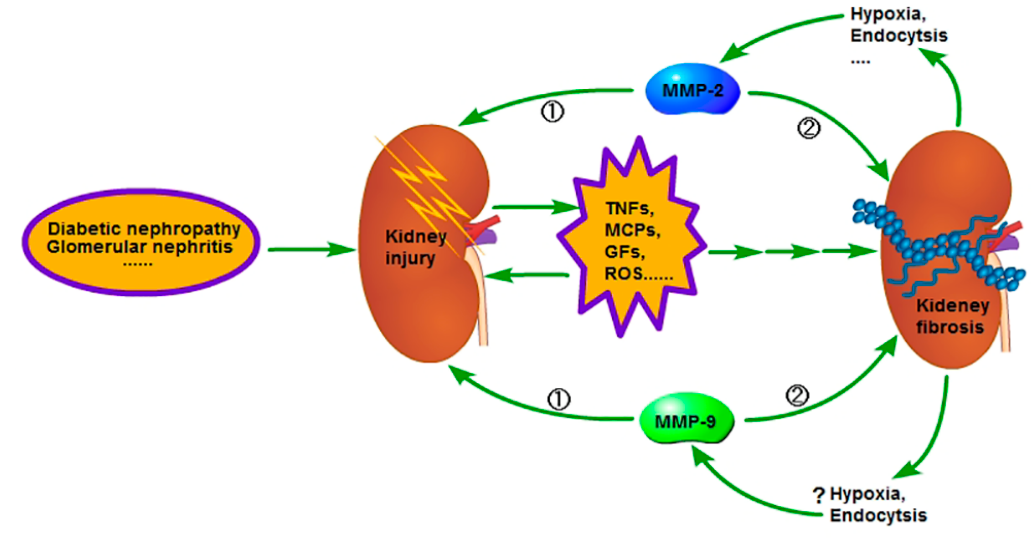
Figure 2. In the early stage of chronic kidney disease (CKD), when the kidney is injured, the injured cells and the inflammatory cells in kidney will secrete a variety of pro-inflammatory and pro-fibrotic cytokines, which promote the occurrence of renal interstitial fibrosis. Meanwhile, the activity of MMP-2 and 9 is increased and the renal basement membrane injured, promoting the phenotype transformation of renal tubular epithelial cells, at last resulting in the aggravation of extracellular matrix (ECM) deposition. However, in the advanced stage of CKD, the activity of MMP-2 and 9 is decreased and leads to inadequate degradation of ECM; therefore, the fibrosis is difficult to reverse. The reason for the activity decrease of MMP-2 in the advanced stage of CKD is related to the enhancement of endocytosis, which is caused by hypoxia, but further studies are needed regarding relation to the reason for the activity decrease of MMP-9 in the advanced stage of CKD. ① Early stage; ② advanced stage.